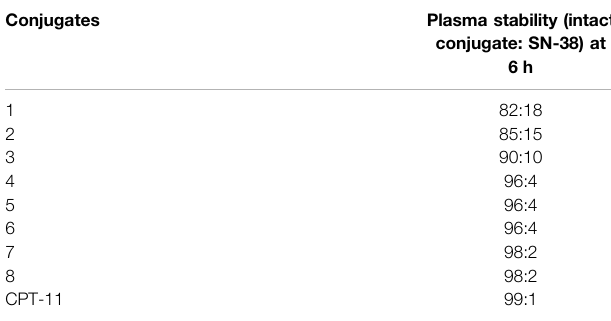
TABLE 1 | In vitro plasma stabilities . Ratio of intact conjugates 1 – 8 and CPT- 11 in comparison to SN-38 after 6 h incubation with mouse plasma. Data of CPT11 were adopted from a previous report (Liu et al.,